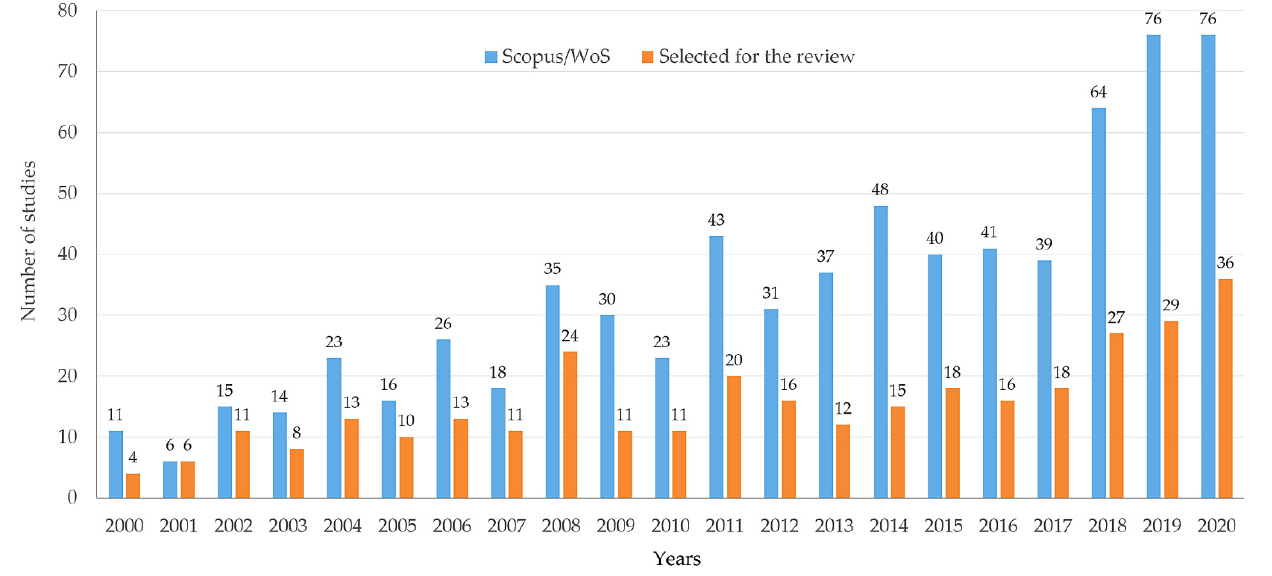
Figure 2. Temporal distribution of available and selected publications from 2000 to 2020 for the review in the field of remote sensing of forest BA, BS, and post-fire recovery, obtained from Scopus and Web of Science databases.